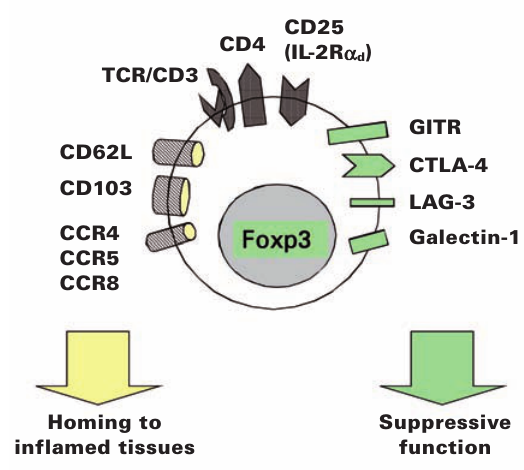
Homing to inflamed